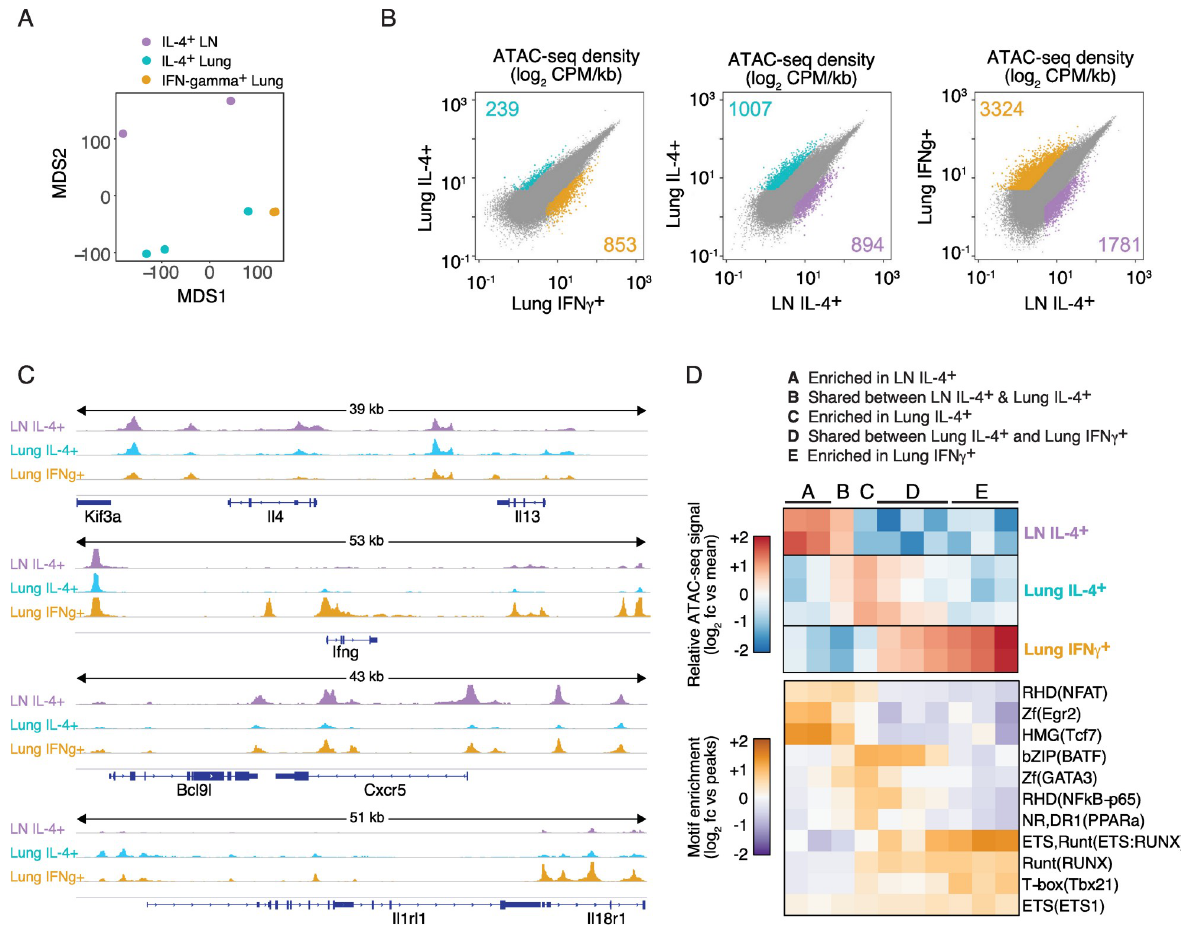
Fig 9. ATAC-sequencing reveals distinct chromatin landscapes among IL-4-expressing CD4 + T cells in the lymph nodes and lung. IL-4 4get and IFN-gamma GREAT C57BL/6 mice were infected with N . brasiliensis and GFP + , YFP + , and reporter-negative CD4 + T cells from the lung or mediastinal lymph nodes were harvested and sorted eight days post-infection for ATAC-sequencing. (A) Multidimensional plot using all accessible chromatin regions to assign similarity among indicated CD4 + T cell subsets. (B) Diagonal scatterplots of mean ATAC-seq counts per peak comparing accessible chromatin regions in the indicated populations. Each point represents a single peak from the ~86,000 peaks observed in the three populations. Colors designate if a peak is differentially accessible ( > 3-fold change) between the two populations (Padj < 0.05). (C) Mean ATAC-seq coverage for Il4 , Il13 , Ifng , Cxcr5 , and Il1rl1 loci with a scale of 0–400 for all tracks. (D) Top: k-means clustered heatmap of log 2 fold- change from global mean at all peaks among indicated IL-4- and IFN-gamma-expressing CD4 + T cell populations. Bottom: relative motif enrichment among unique peaks from each cluster (Top) are compared to all ATAC-seq peaks; n = 2–3 mice, from a single experiment.